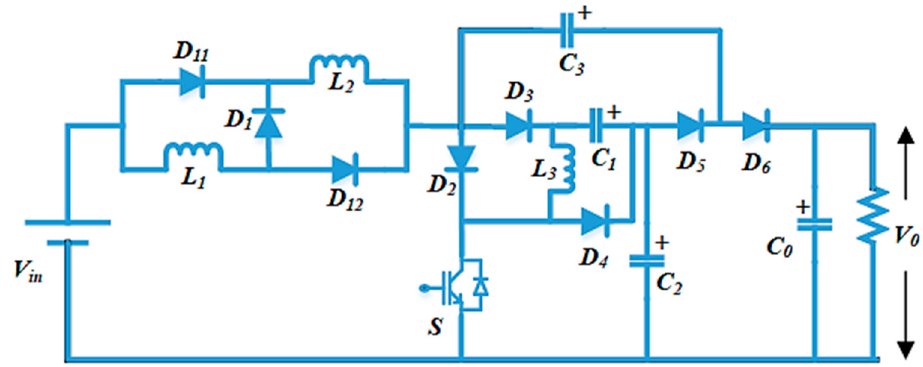
Figure 3. Circuit diagram of proposed HG-SIQBC.